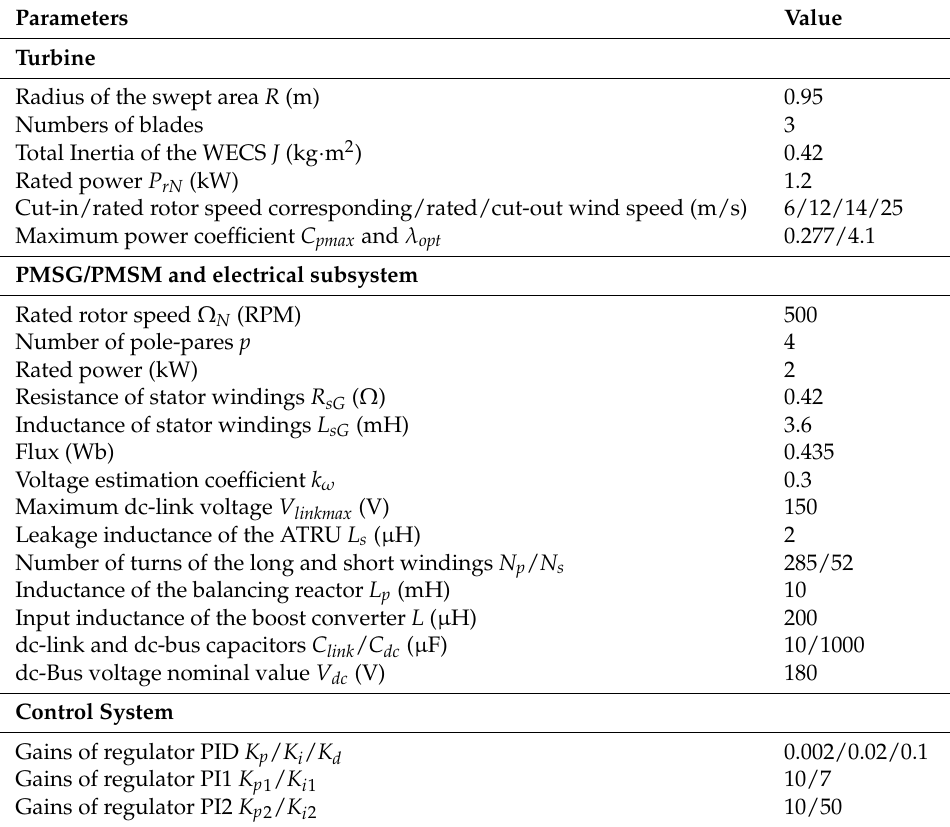
Table A1. System